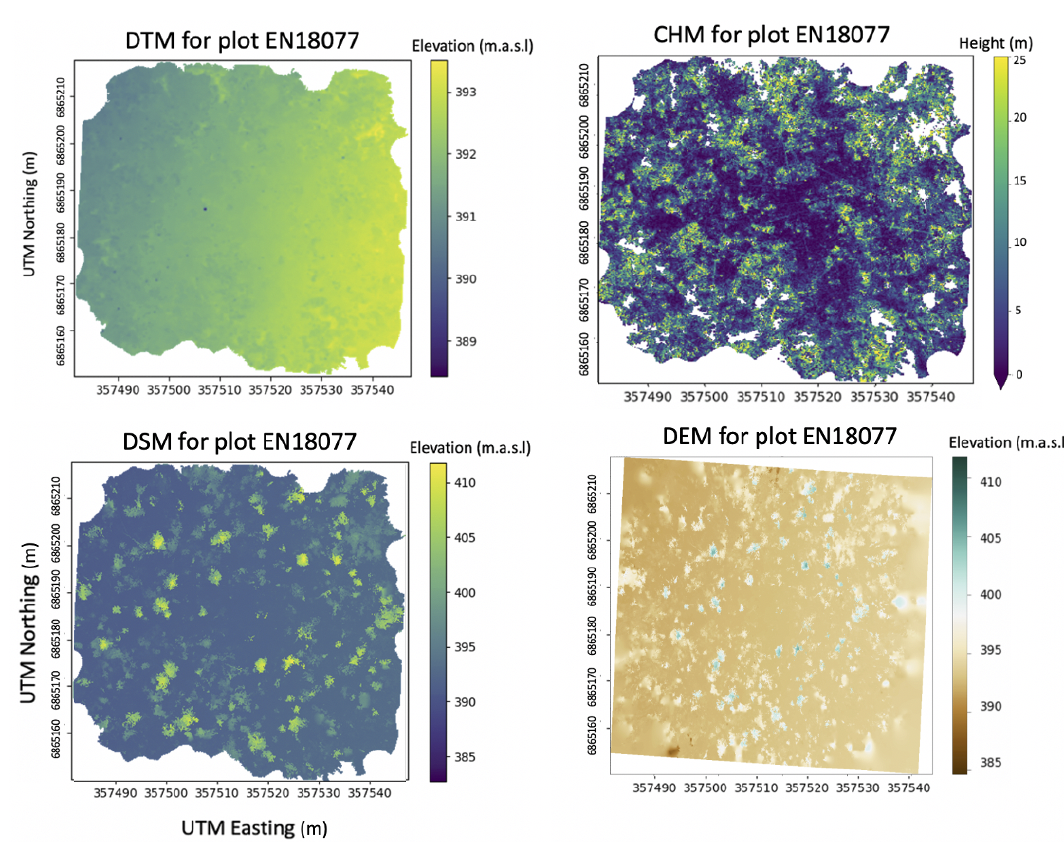
Figure 13. Digital terrain model (DTM), canopy height model (CHM), digital surface model (DSM) for plot EN18077.